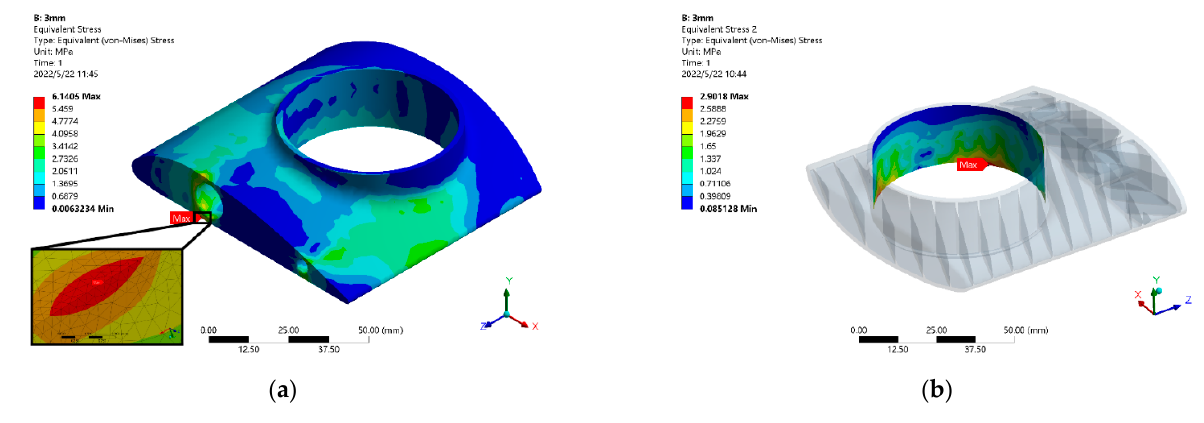
Figure 13. Stress results of the optimized wingtip component with filling structure. ( a ) Stress results of optimized model; ( b ) stress results at the duct installation hole in the optimized